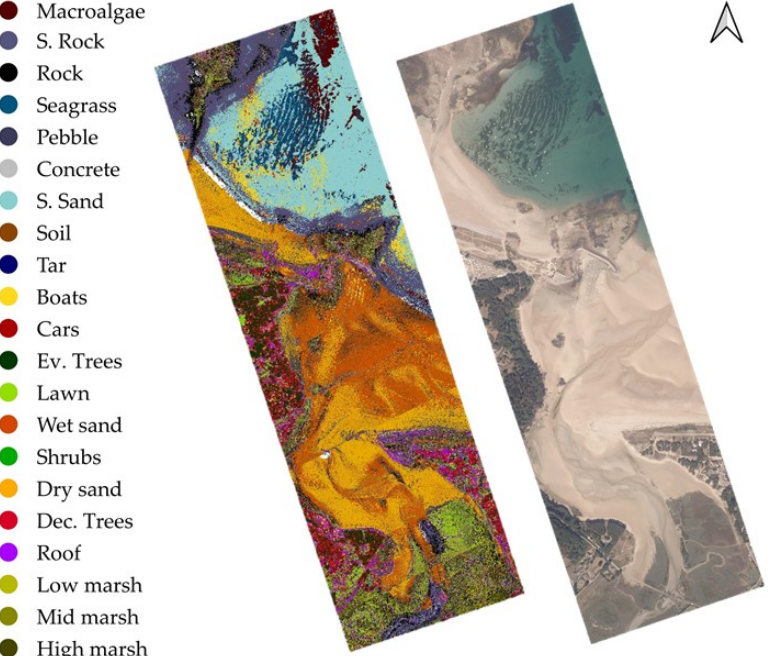
Figure A1. Projected 3D map of the habitats obtained with the predictions of a random forest classifier on green spectral features; orthoimage of the study area. The orthoimage was captured in 2014, while lidar data are not contemporaneous as they date from 2019. S. = submerged, Ev. = evergreen, Dec. = deciduous.